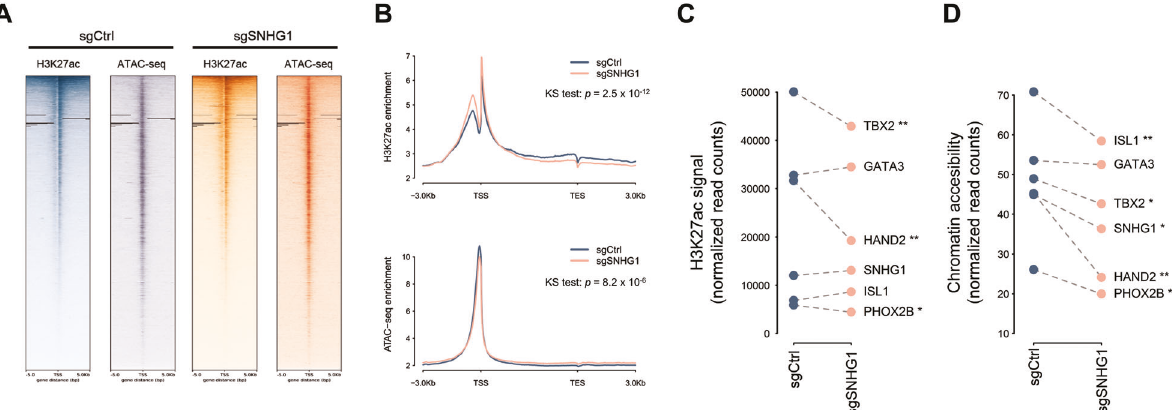
Fig. 4 Chromatin state in cells with high and low SNHG1 expression. A Heatmaps of ChIP-seq and ATAC-seq tag densities in control (sgCtrl) and SNHG1 -depletion (sgSHNG1) cells. Data are shown in a + / − 5 kb region. B ChIP-seq and ATAC-seq average pro fi les in control (sgCtrl) and SNHG1 -depletion (sgSHNG1) cells across H3K27ac regions. KS: Kolmogorov – Smirnov test. C The acetylation levels of H3K27 in CRC transcription factors ( n = 2). D The chromatin states of CRC transcription factors ( n = 2). * p < 0.05, ** p < 0.01 from t